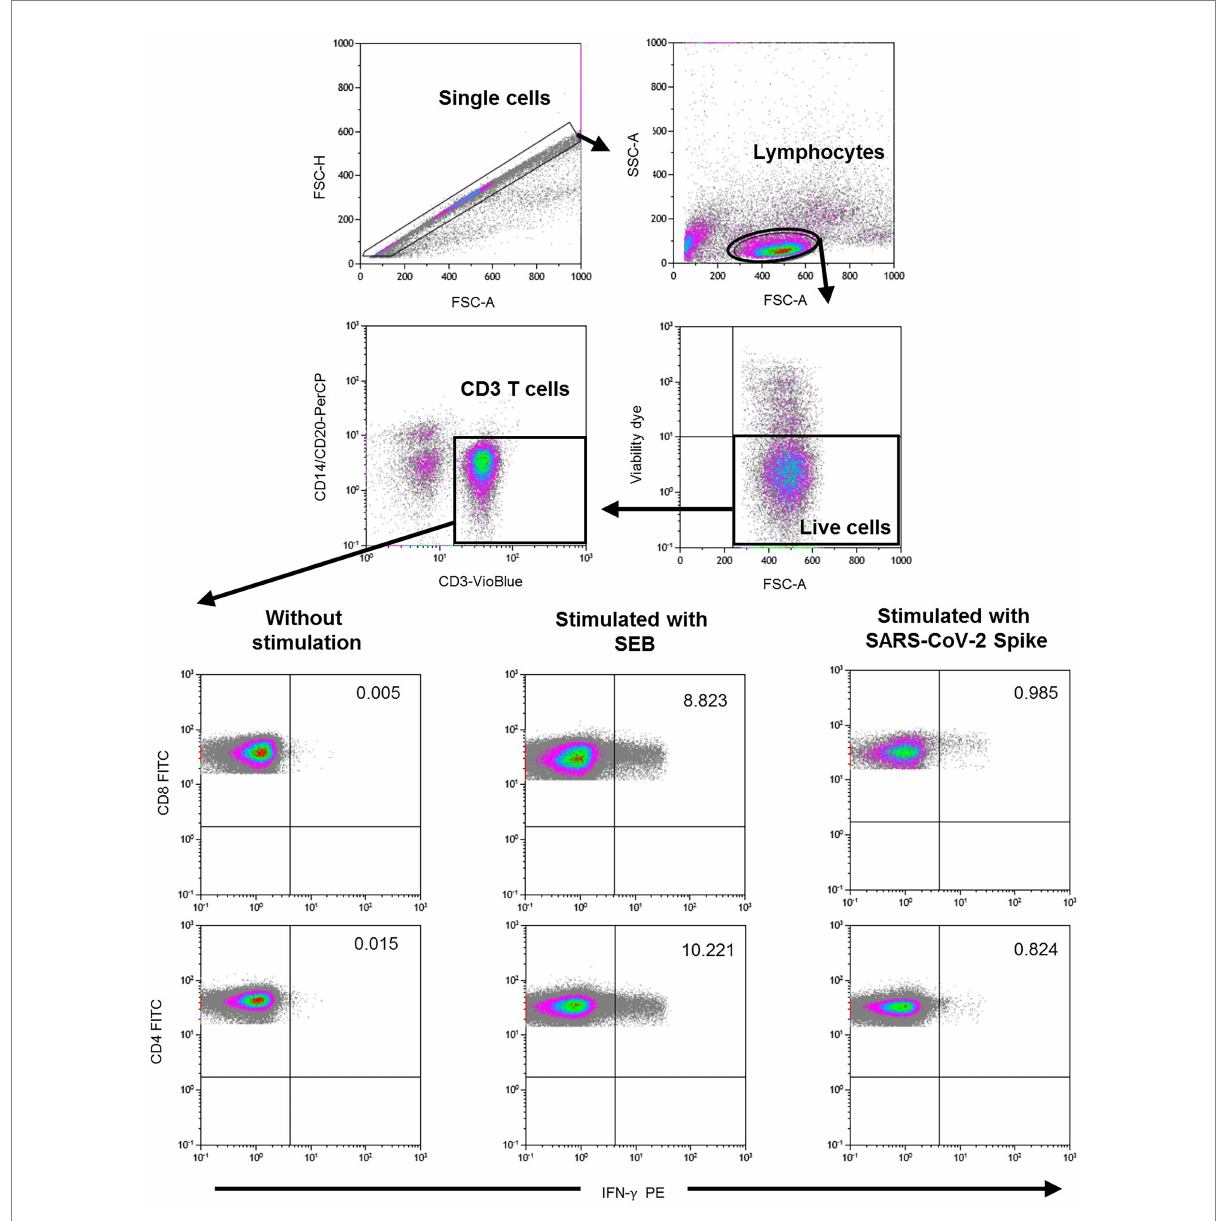
FIGURE 2 Flow cytometry gating strategy for the quantification of SARS-CoV-2 spike specific T cells. After stimulation with the spike peptide, staining of the cells was carried out with the following fluorochromes-conjugated antibodies: CD3-VioBlue, CD4-APC, CD8-FITC, CD14-PerCP, CD20-PerCP, IFN- γ -PE, and FcR blocking reagent. To exclude dead cells, viability 405/520 fixable dye staining was added for the last 10 min of incubation. Samples were measured and analyzed by flow cytometry on a MACSQuant Analyzer 10 using MACSQuantify software. At least 10 5 cells were analyzed and gated with the following strategy: Single (FSC-A/FSC-H dot plot) and live cells were first selected. Cell debris, monocytes, and B cells were excluded from the analysis with CD14-and CD20-PerCP antibodies. Then, lymphocytes were selected with a FSC-A/SSC-A dot plot, and CD3 T cells were gated. IFN- γ expression was finally analyzed separately for CD4 + and CD8 + T cells. A representative sample of negative control (without stimulation), positive control (stimulated with SEB), and with SARS-CoV-2 Spike peptide are shown in the lower